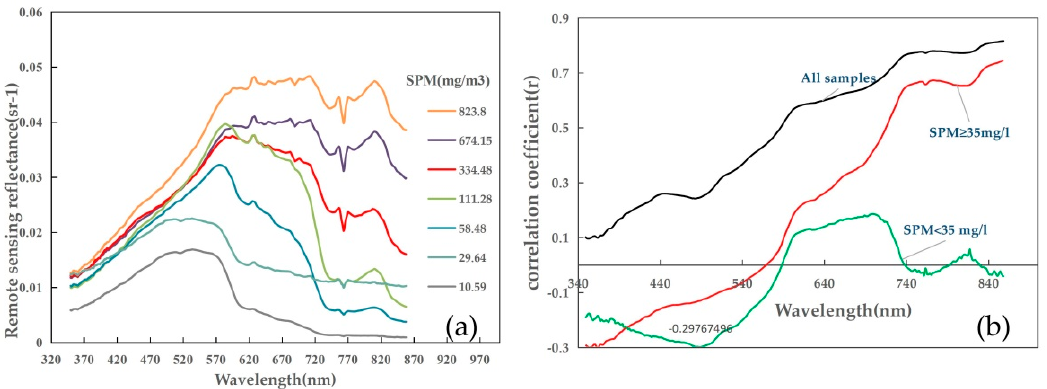
Figure 2. ( a ) The field measured spectral with different SPM concentrations in the study area. ( b ) The correlation coefficient (r) between the field measured SPM concentration and R rs varied with the wavelength. In the figure, the black, red and green line were calculated respectively based on the whole (N = 48, 5.51–2061.3), high (N = 26, SPM ≥ 35 mg/L) and low (N = 22, SPM < 35) SPM concentration ranges.